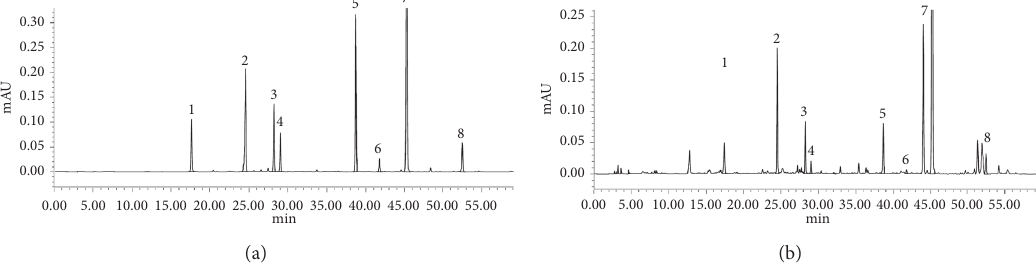
Figure 2: HPLC chromatogram of mixed standard solution (a) and Angelica test solution (b). Note. 1, chlorogenic acid. 2, ferulic acid. 3,